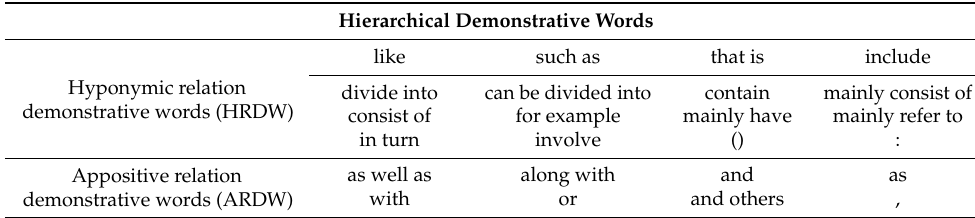
Table 2. Statistical table of hierarchical relation demonstrative words.